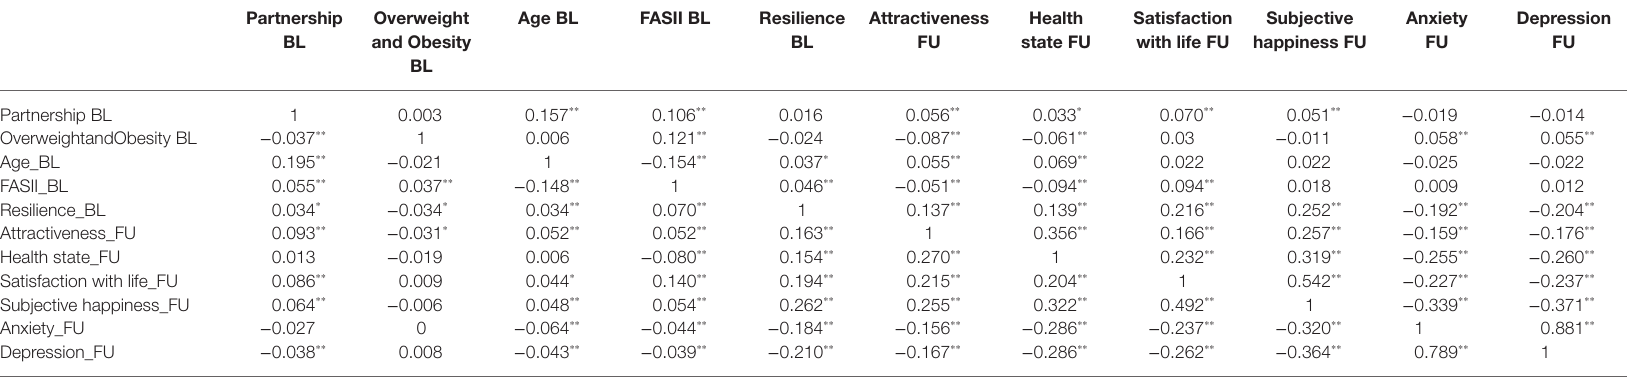
TABLE 2B | Bivariate correlations among the psychological predictors within China, with female below diagonal and male above